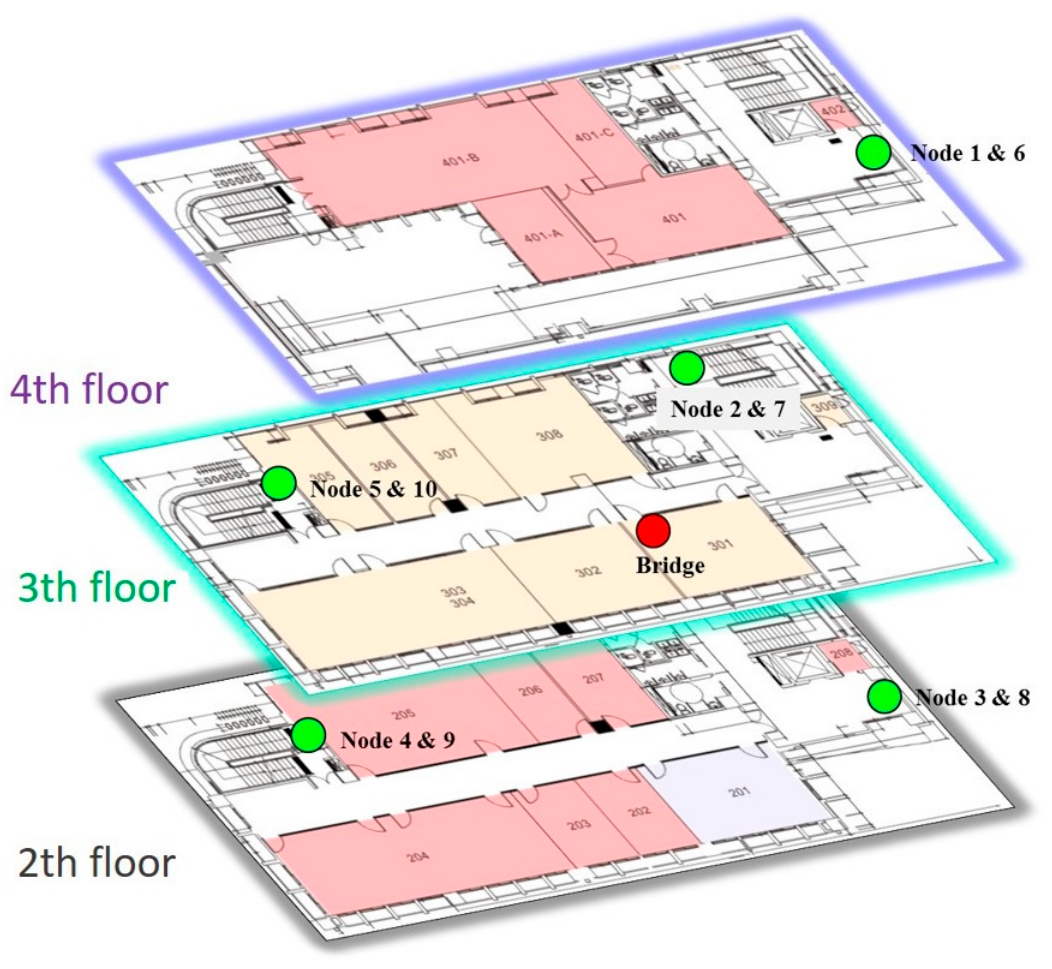
Figure 13. Experimental bridge and nodes placement map.